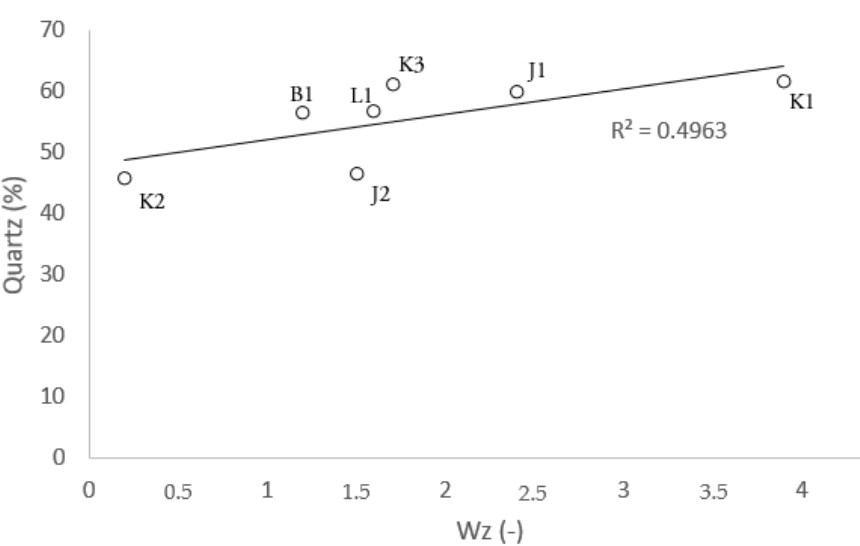
Figure 22. Relationship between quartz content and abrasivity index W z of tested sandstones.